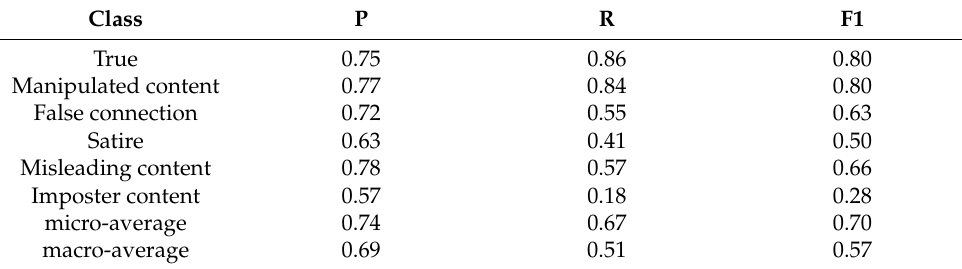
Table 8. Results of BiLSTM with dynamic Glove vectors.